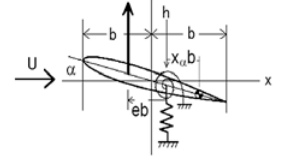
Fig. 1. Typical section